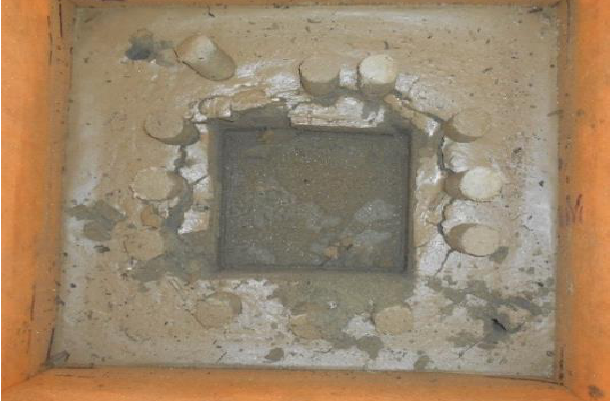
Fig. 7. Penetration of structure inside the ground after shaking